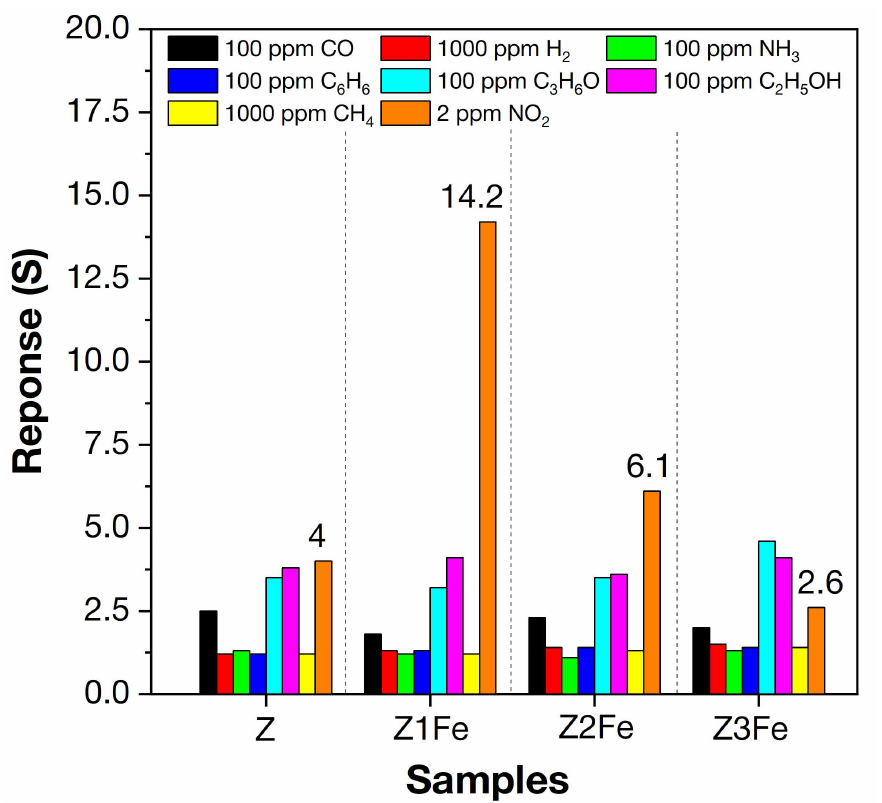
Figure 9. Selectivity histogram of the samples to various gases (H 2 , CH 4 , CO, C 6 H 6 , NH 3 , ethanol, acetone, and NO 2 ) at 175 ◦